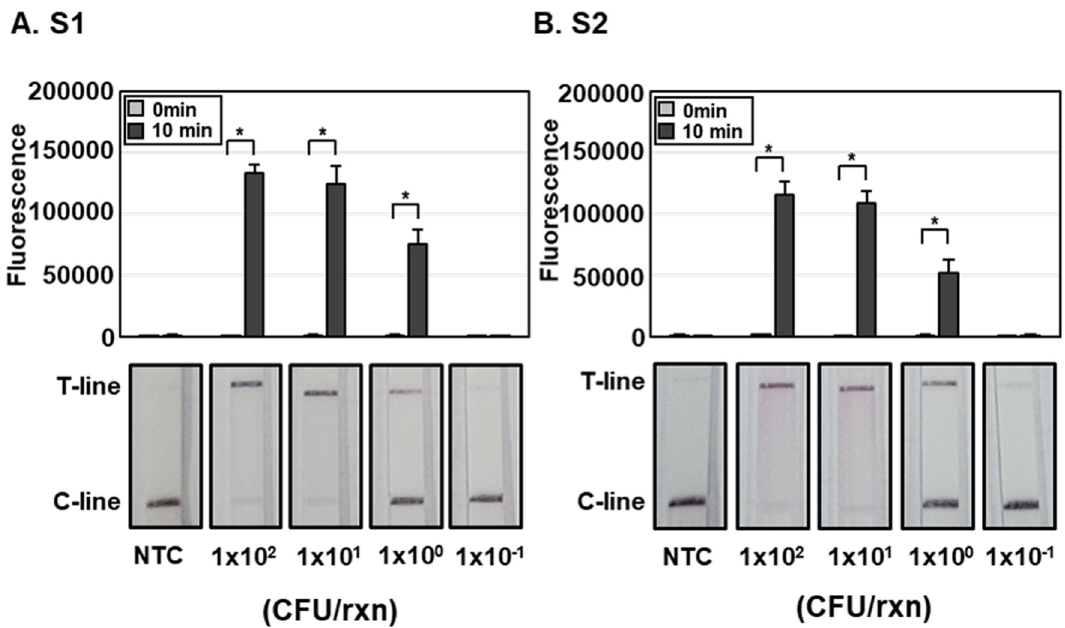
Fig 3. Sensitivity of SFTSV DETECTR. Different concentration of lentiviruses pseudotyped with SFTSV S gene (1.0 × 10 − 1 to 1.0 × 10 2 CFU per reaction) were lysed through HUDSON and viral nucleic acids amplified via RT-RPA with a primer set specific for the SFTSV S gene. RT-RPA amplicons were detected using SFTSV DETECTR combined with fluorescence assay or lateral flow using gRNAs (A) S1 and (B) S2 corresponding to the S genes of all SFTSV genotypes. Fluorescence saturation occurred within 10 min. Lateral flow assay results were evaluated 2 min after the strip was reacted with the sample. Values are presented as means ± s.d. (error bars) ( n = 3 replicates; � p < 0.05 between samples, two-sample t -test). C-line, control line; T-line, test line; NTC, no template control. CFU, colony forming